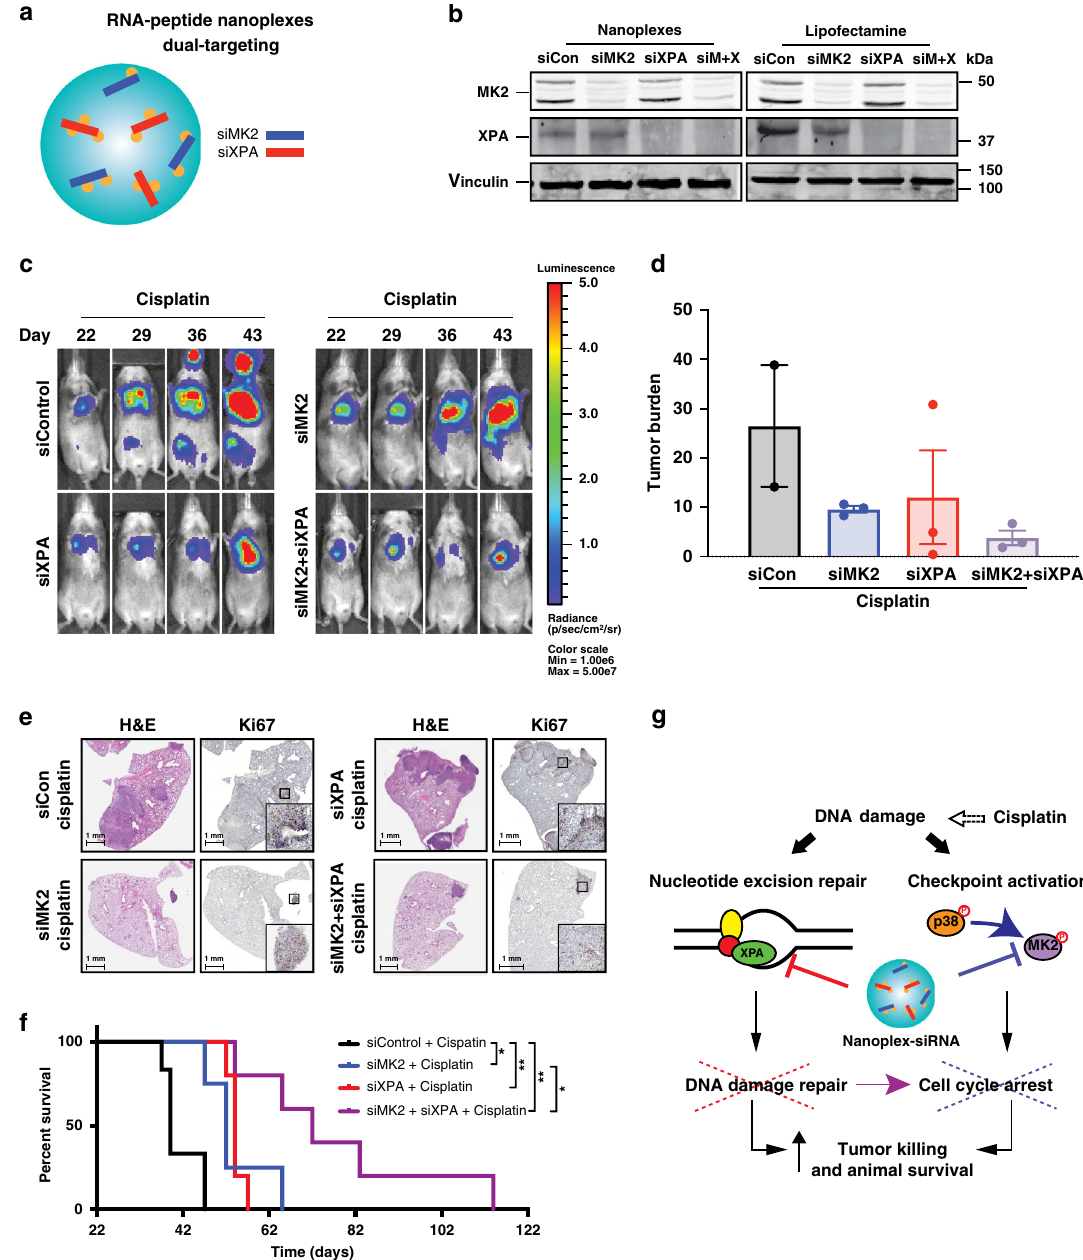
Fig. 4 Augmented synthetic lethality for Pt by co-targeting XPA and MK2 in vivo. a Schematic of dual-targeting peptide-based nanoplexes. b MK2